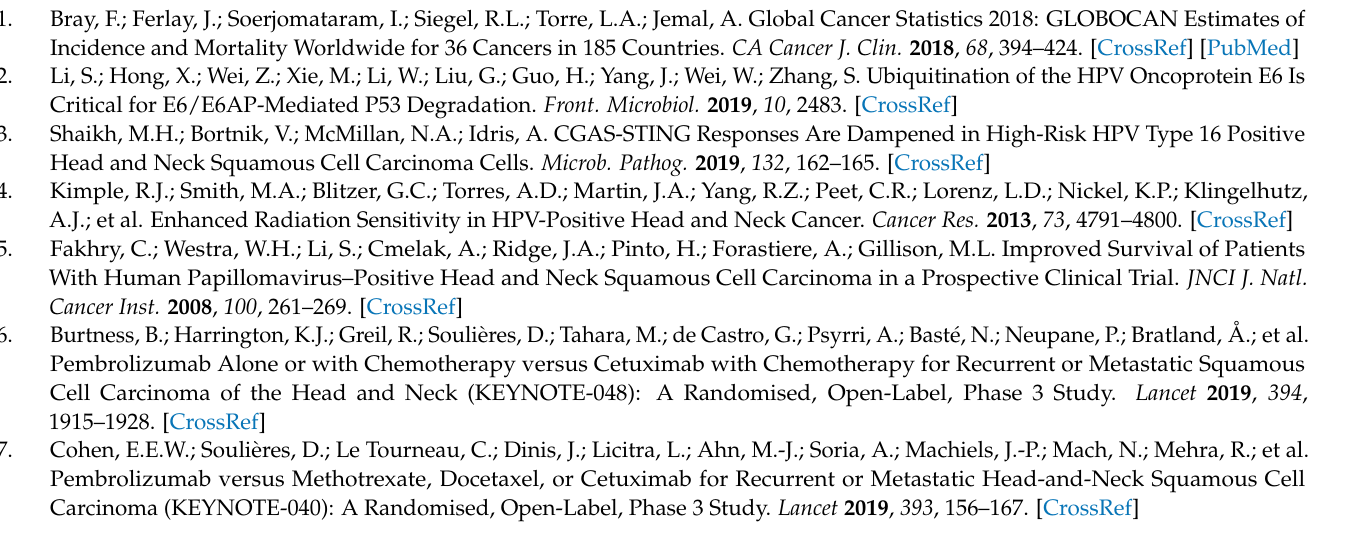
merged. Figure S2. Immune infiltration score associated with FDCSP in HNSC (GEO cohorts). Figure S3. HNSC immune infiltration in TCGA and GEO cohorts. Figure S4. Immune cell correlation in the high/low FDCSP group of HPV+ HNSC (GEO cohorts). Figure S5. Expression of FDCSP in WT/Mutated TP53 in HPV+/ − HNSC (GSE65858 cohort) and the expression of CXCL13 in HNSCs (TCGA,